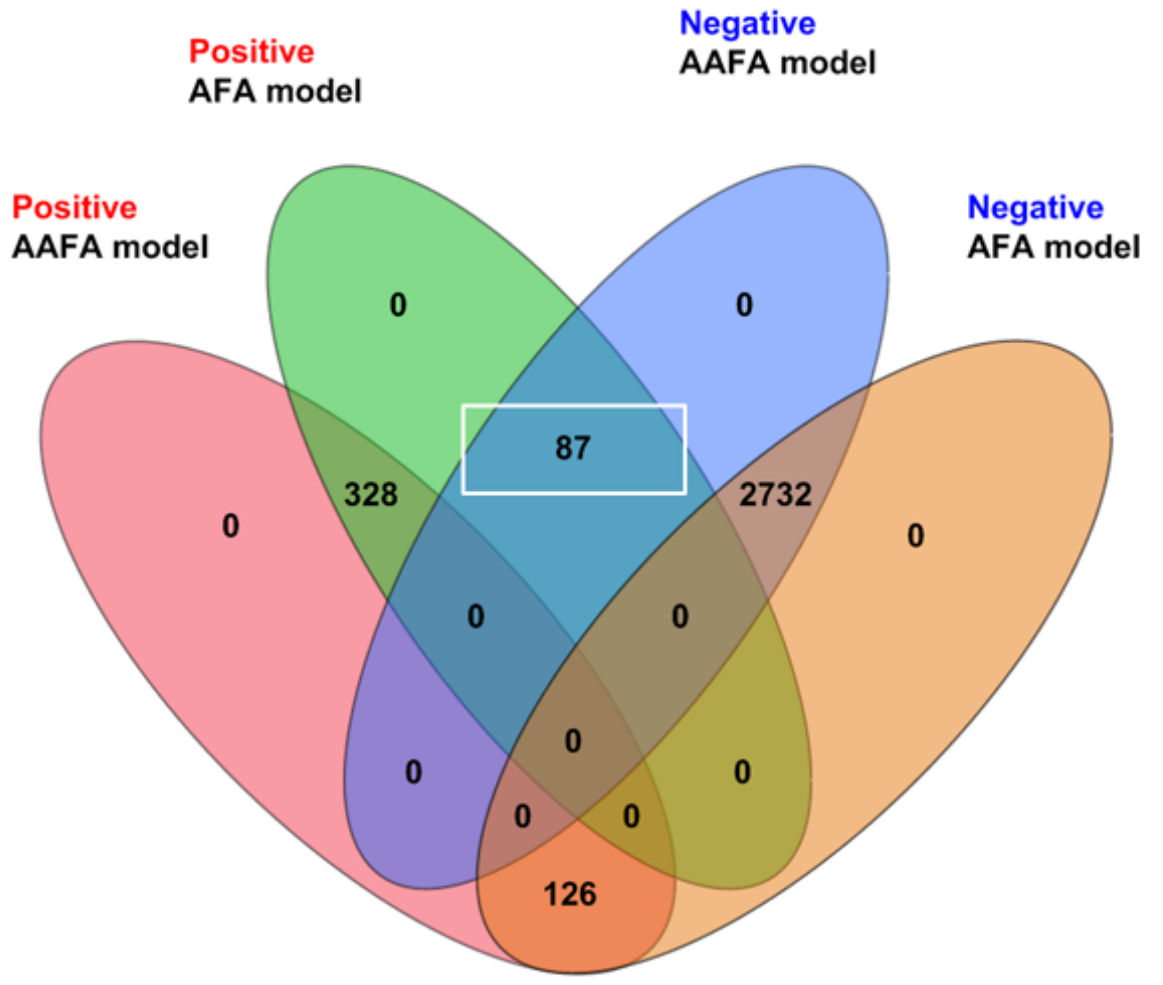
Figure 1. Comparison of the performances of the AFA and AAFA models in the 2018 validation